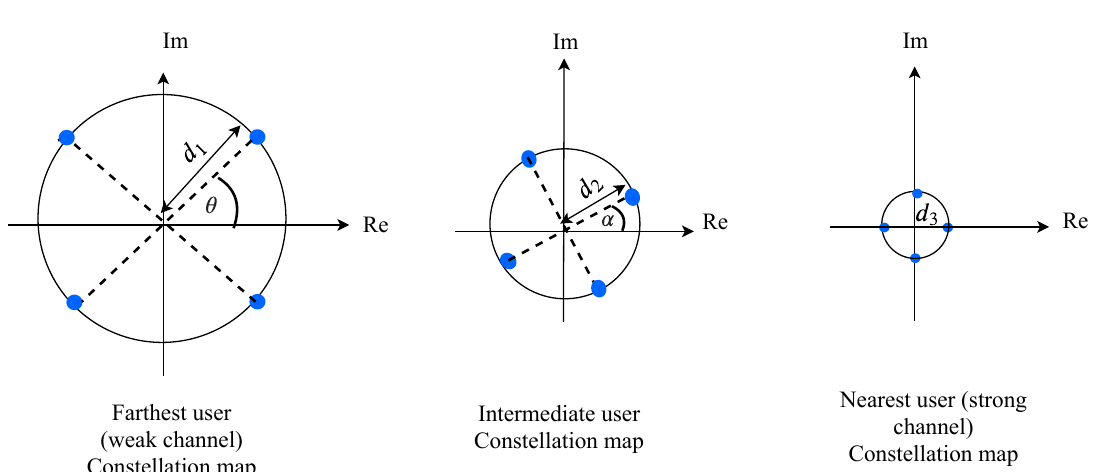
Figure 6. A sample constellation mapping design for 3 users under NOMA principle, where each user has a unique constellation mapping. A unique constellation map is assigned to each user at the transmitter in order to reduce the inter-symbolic interference and the complexity of decoding at the end